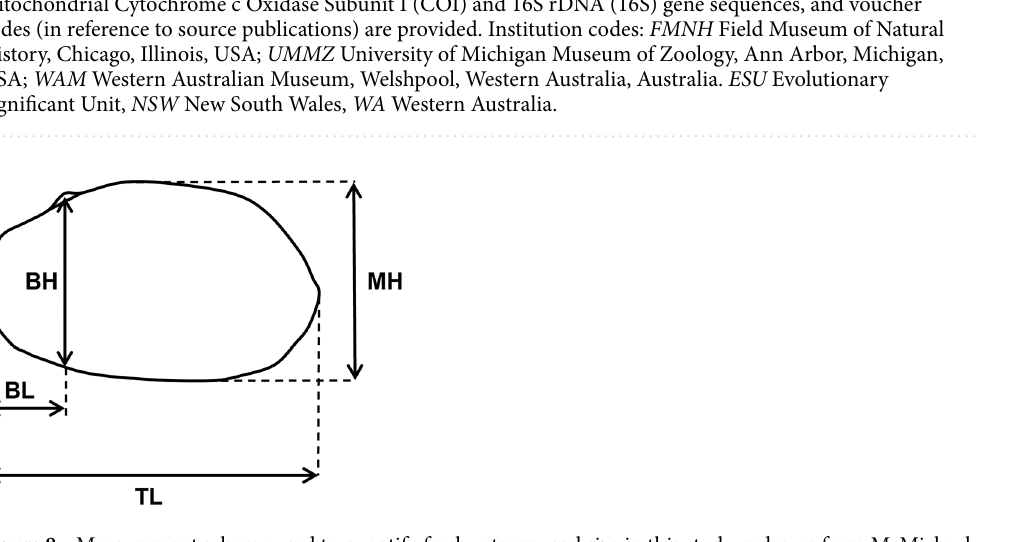
Figure 8. Measurement scheme used to quantify freshwater mussel size in this study, redrawn from McMichael & Hiscock 10 . BH beak height, BL beak length, MH maximum height, TL total